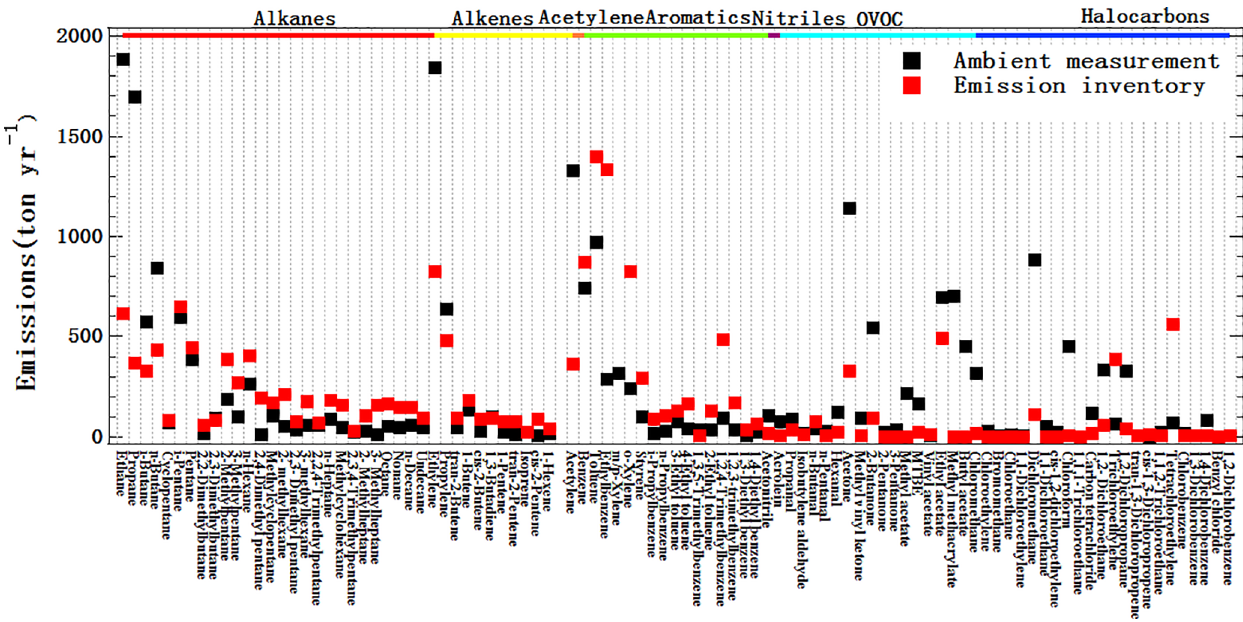
Figure 7. Comparisons of individual species emissions (t) derived from the ambient measurements and emission inventory for the PKU site (0.25 ◦ × 0.25 ◦